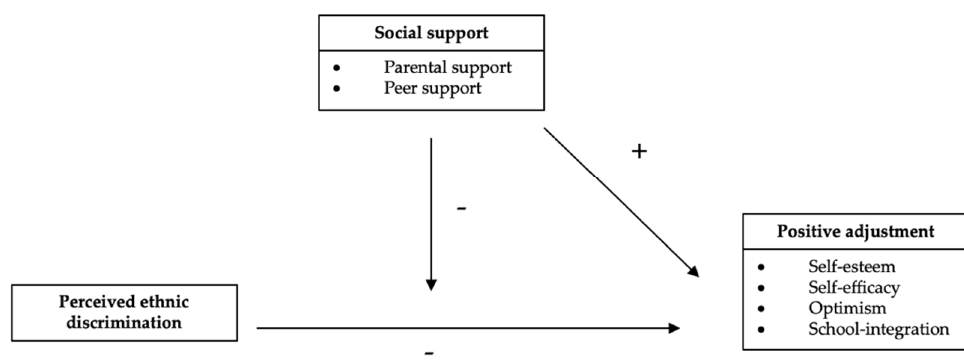
Figure 1. Summary of expected relations.